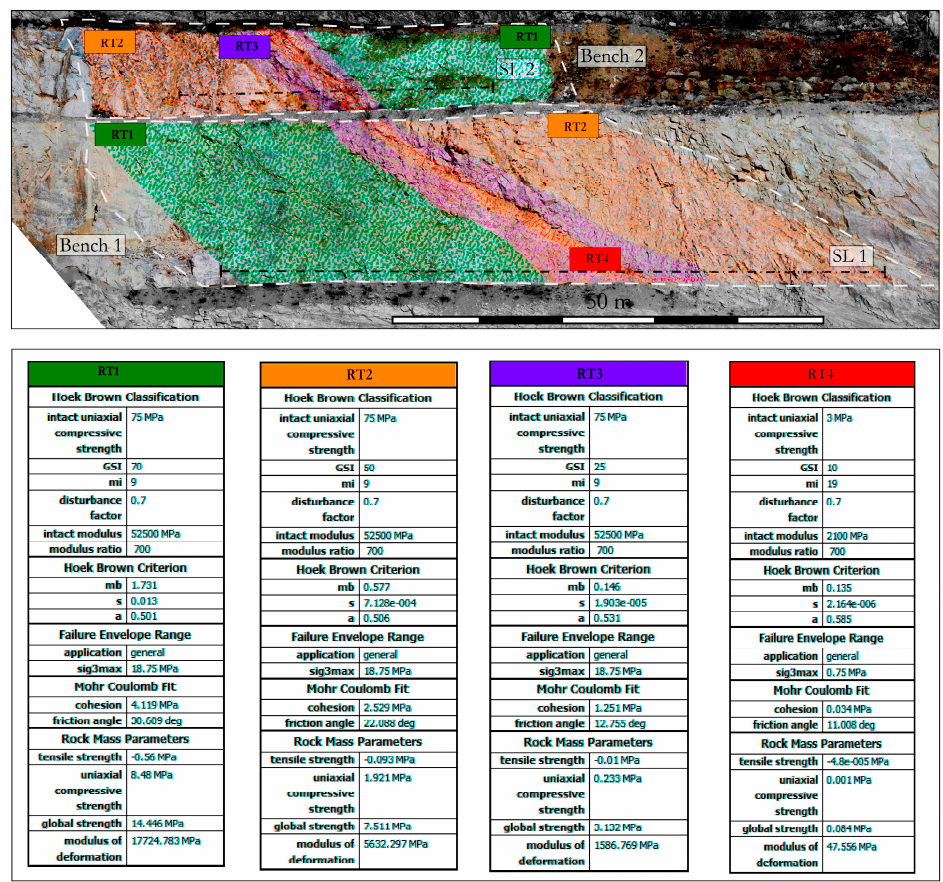
Figure 6. Rock mechanics field characterization for the four identified litho-technical units.